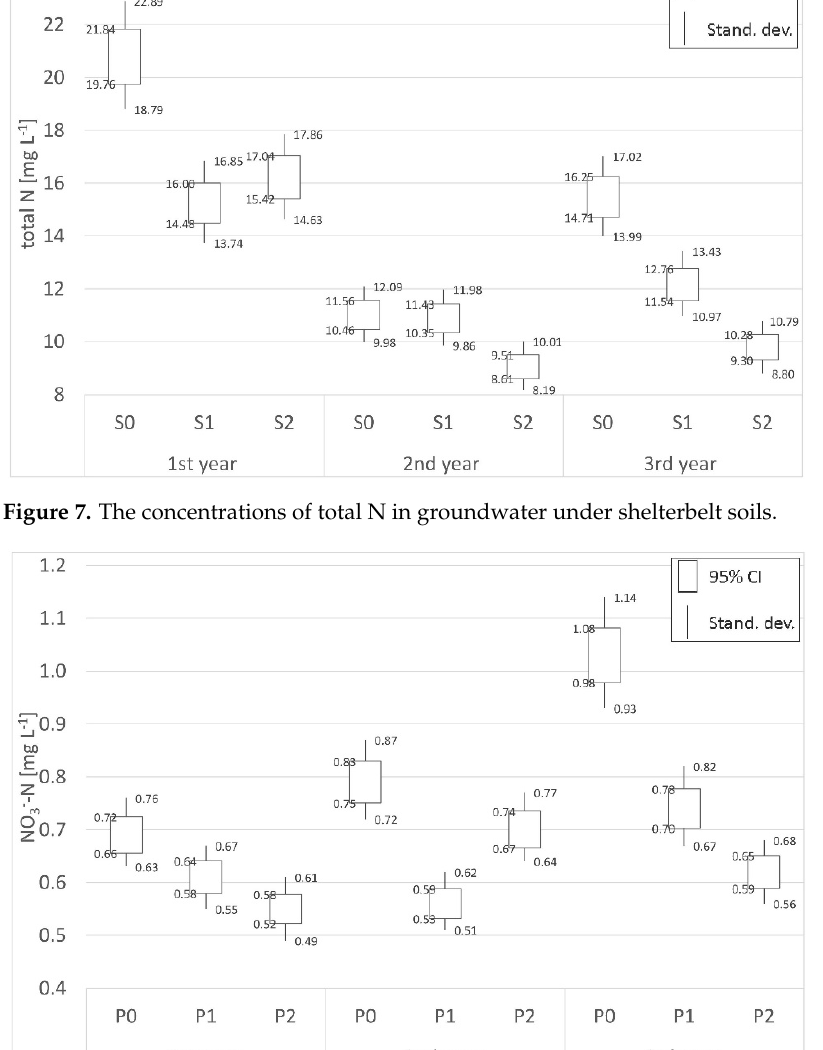
Figure 6. The concentrations of total N in groundwater under peatland soils.